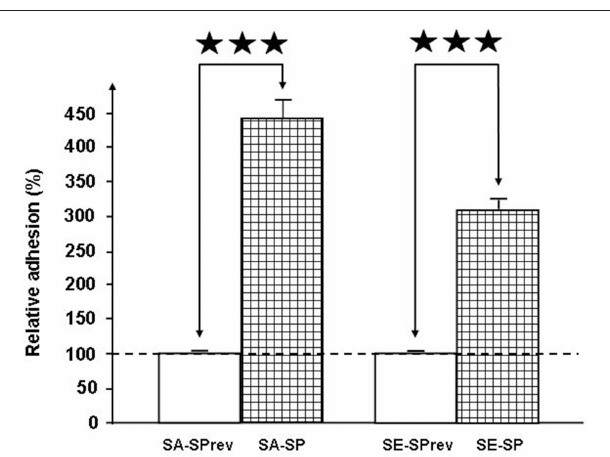
FIGURE 5 | Effect of Substance P (SP) and Substance P reverse (SPrev) (10 − 6 M) on the adhesion properties of S. aureus MFP03 and S. epidermidis MFP04 on HaCaT keratinocytes. The dotted line indicates the basal adhesion of bacteria (100%) in the absence of treatment (control). Each value is the mean ± SEM of three independent experiments ( ⋆⋆⋆ p <